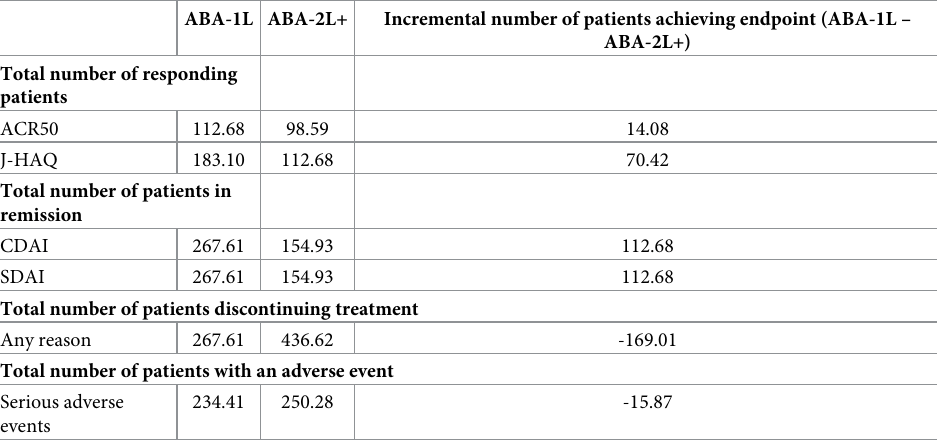
When comparing ABA-1L and ABA-2L+ in the hypothetical cohort, the number of ACR50 responders in ABA-1L was higher than that in ABA-2L+ (113 and 99, respectively). The num- ber of patients in both CDAI and SDAI remission in ABA-1L (268 and 268, respectively) was higher compared with that in ABA-2L+ (155 and 155, respectively) (Table 7). More patients discontinued treatment with ABA-2L+ compared with ABA-1L (437 versus 268, respectively), and patients on ABA-2L+ also experienced more SAEs than patients on ABA-1L (250 versus 234, respectively). The overall additional cost of using ABA-1L compared with ABA-2L+ equalled 81 JPY (0.8 USD) PMPM over the 2-year time horizon, and the cost per outcome showed similar results Table 7. Health outcomes per cohort for the overall AMPLE population after 2 years (ABA-1L vs. ABA-2L+).